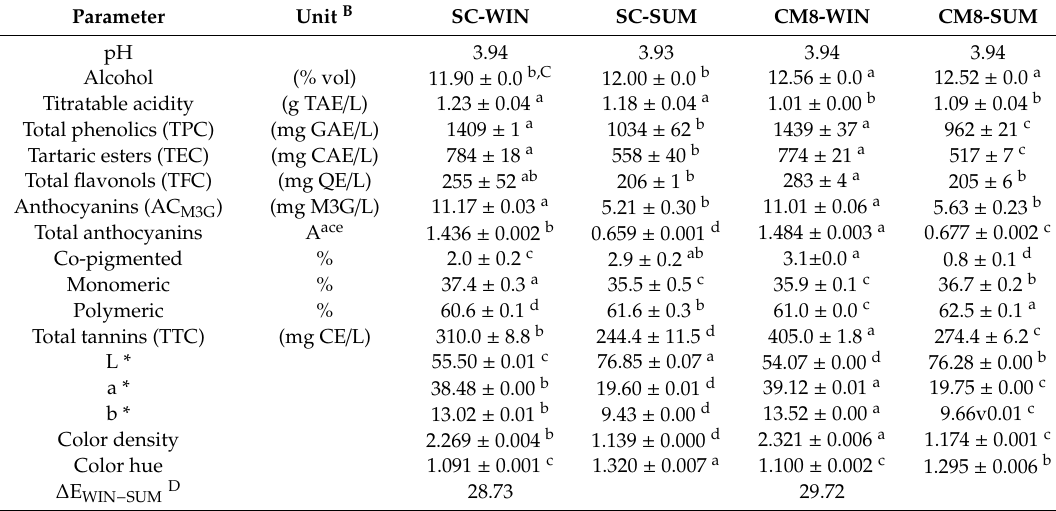
Table 2. E ff ects of starters and seasonal grapes on the chemical and colorimetric characteristics of the red wines studied A .